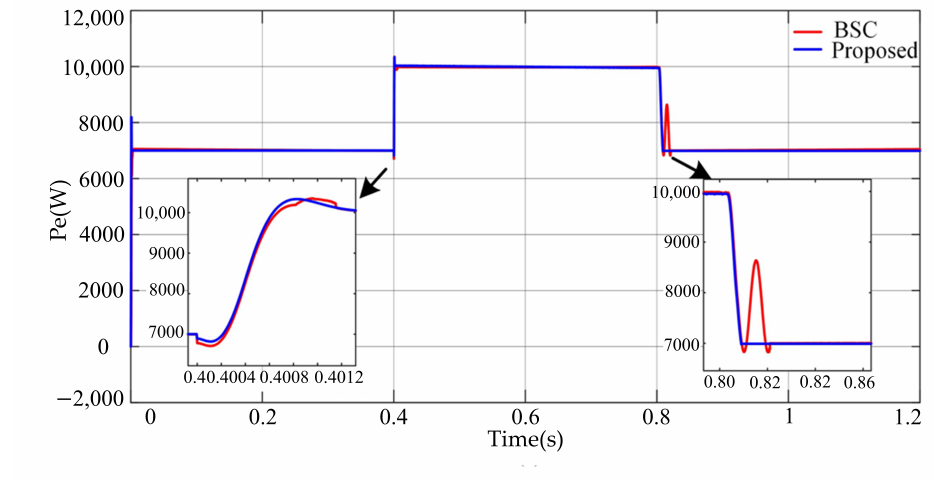
Figure 5. Active power variation result of case-1.